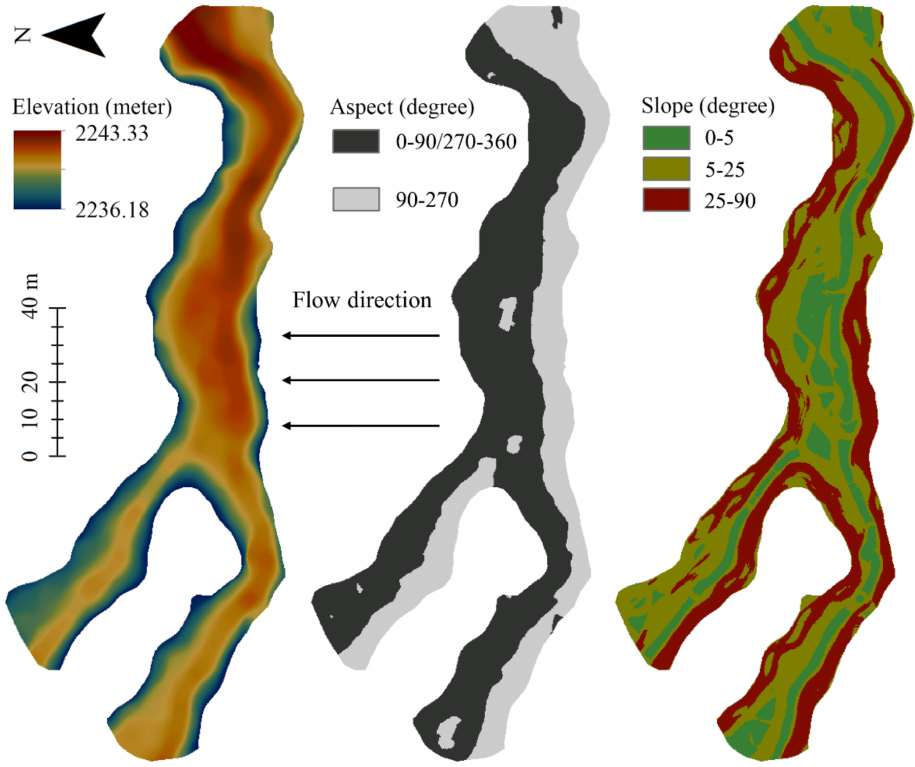
Figure 6. Elevation, aspect and slope of the submerged tufa